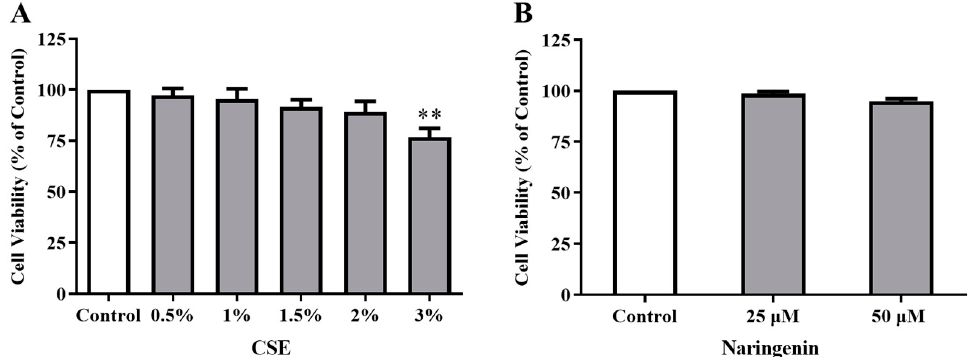
Figure 4. Effects of CSE ( A ) and naringenin ( B ) on cell viability of Beas-2B cells by MTT assays. Results are presented as the percentage of absorbance to the control group. Data are expressed as the means ± SD of five independent experiments for each data point (** p < 0.01 vs. Control).